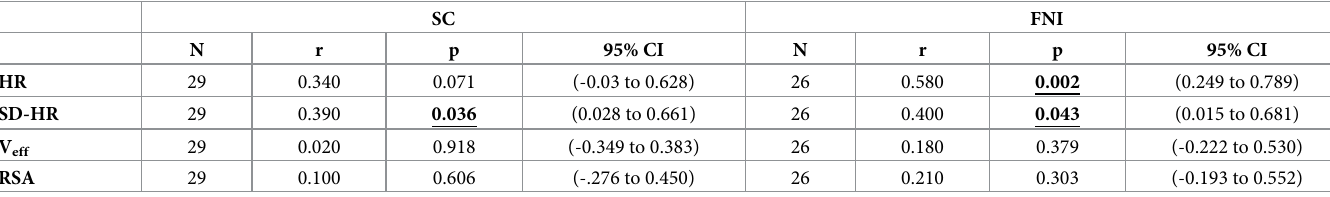
Table 5. Partial correlations between child and mother lap test autonomic variables at the 4–5 year follow-up visit. Correlations were adjusted for effects of sex, gesta- tional age, body weight, corrected age at testing, twin status on both the child and mother values. SC FNI